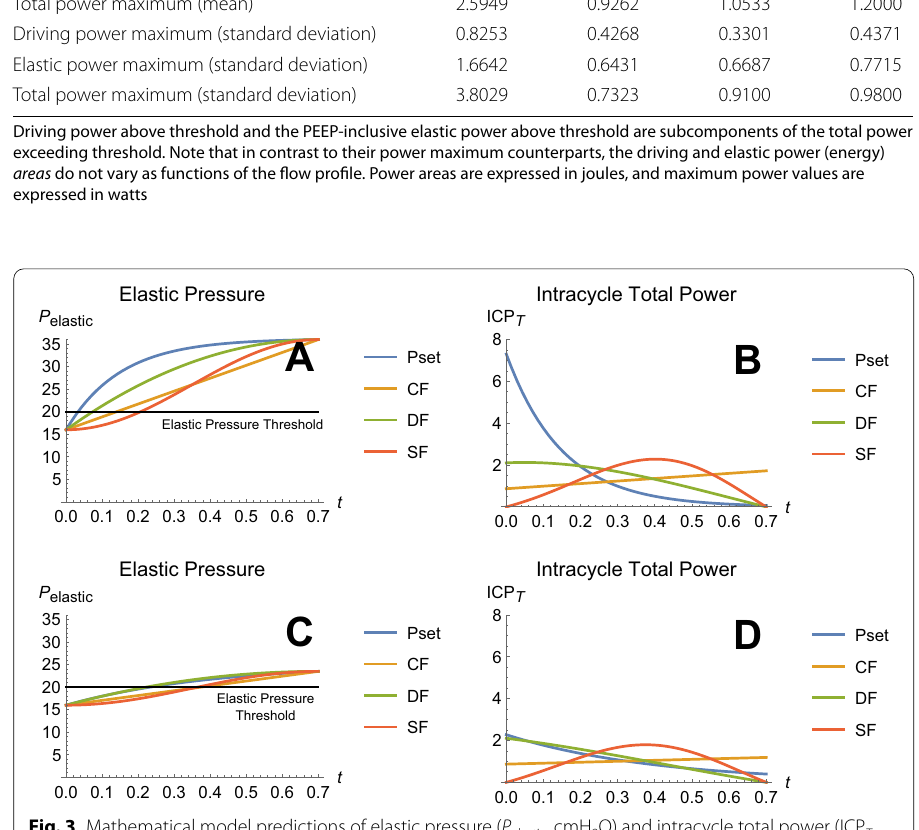
Fig. 3 Mathematical model predictions of elastic pressure ( P elastic , cmH 2 O) and intracycle total power (ICP T , watts) versus inflation time ( t) in response to each of four flow profiles applied in ARDS: pressure control, P set ; constant flow, CF; decelerating flow DF; and sinusoidal flow, SF. Severe ARDS (panels A and B) is compared with mild ARDS (panels C and D). Tidal volume, inspiratory time and flow resistance settings were identical for each